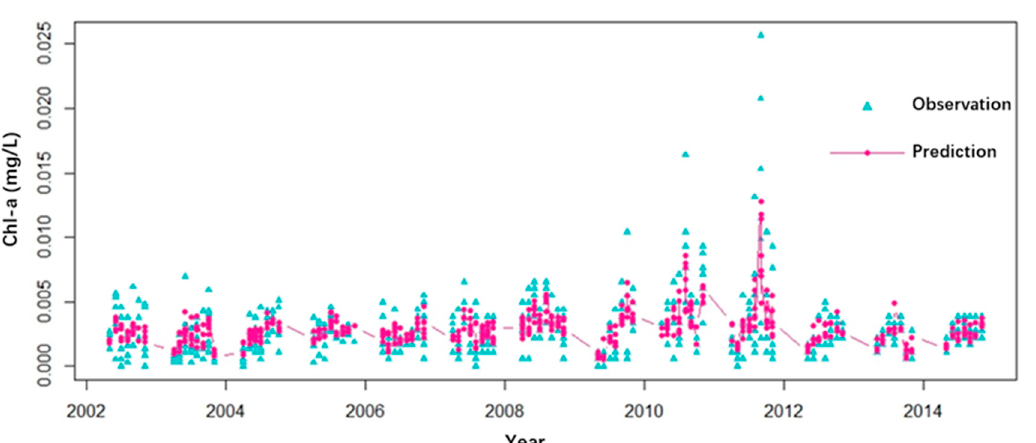
Figure 4. Prediction results of RF model in train stage.